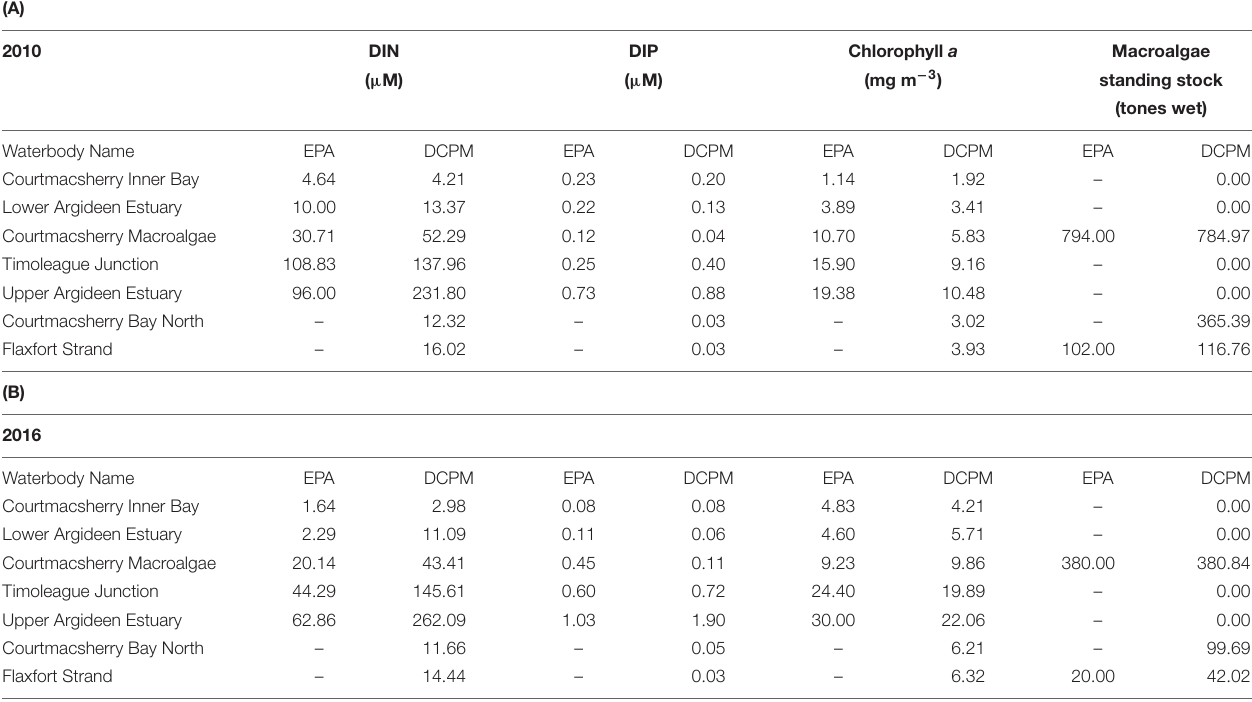
TABLE 4 | Summer N, P, chlorophyll a and macroalgae observations in the Argideen Estuary/Courtmacsherry Bay system area compared to DCPM simulated summer averages after calibration for (A) 2010 and (B) 2016.